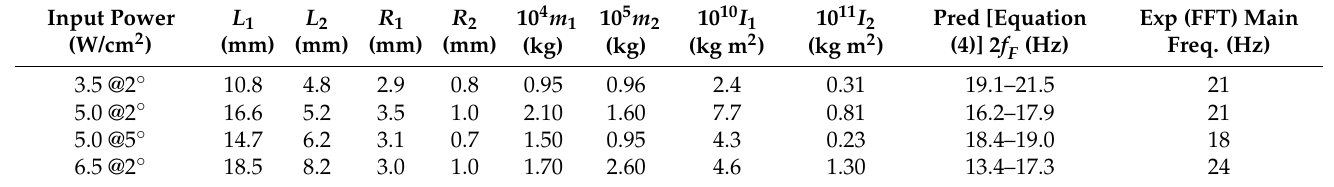
Table 1. Comparison of model-predicted and FFT-evaluated values for fountain-swinging